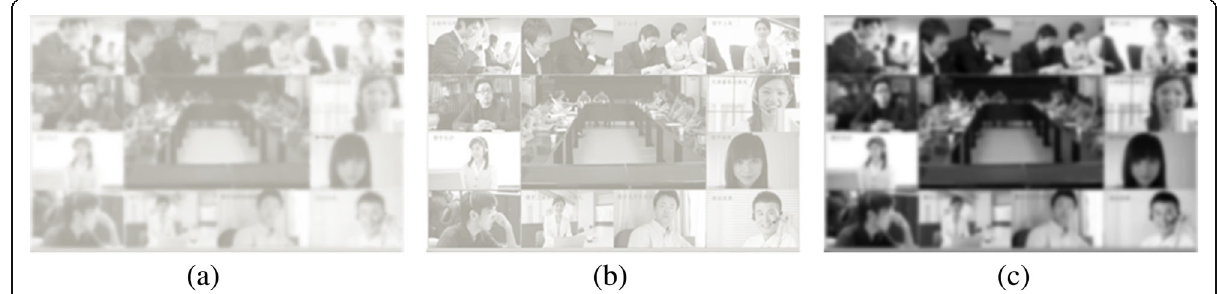
Fig. 5 a – c Comparison of image grayscale processing results